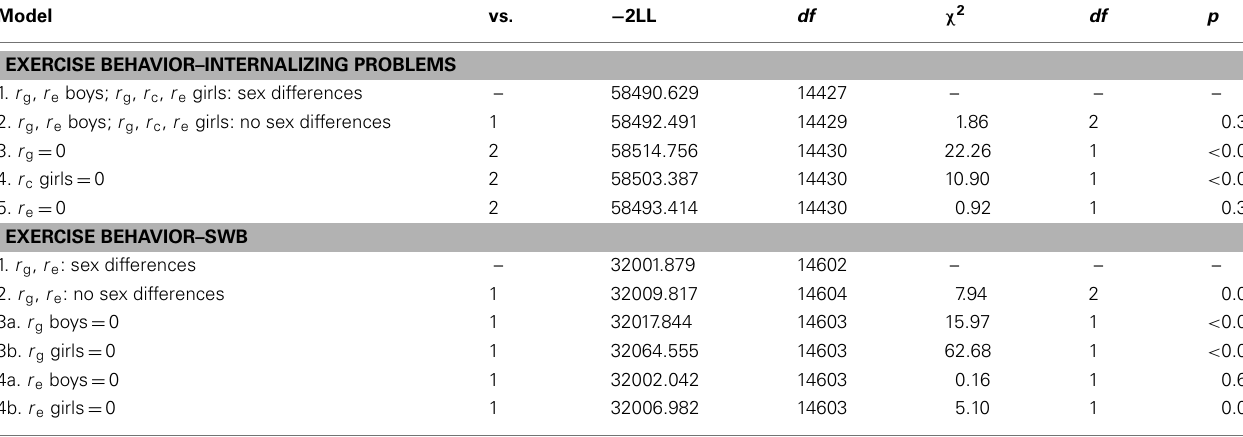
Table 3 | Bivariate model fitting results for exercise behavior and internalizing problems and SWB. Model